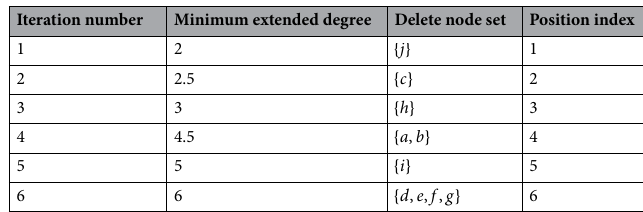
Table 2. The E-shell decomposition procedure of the simple network.